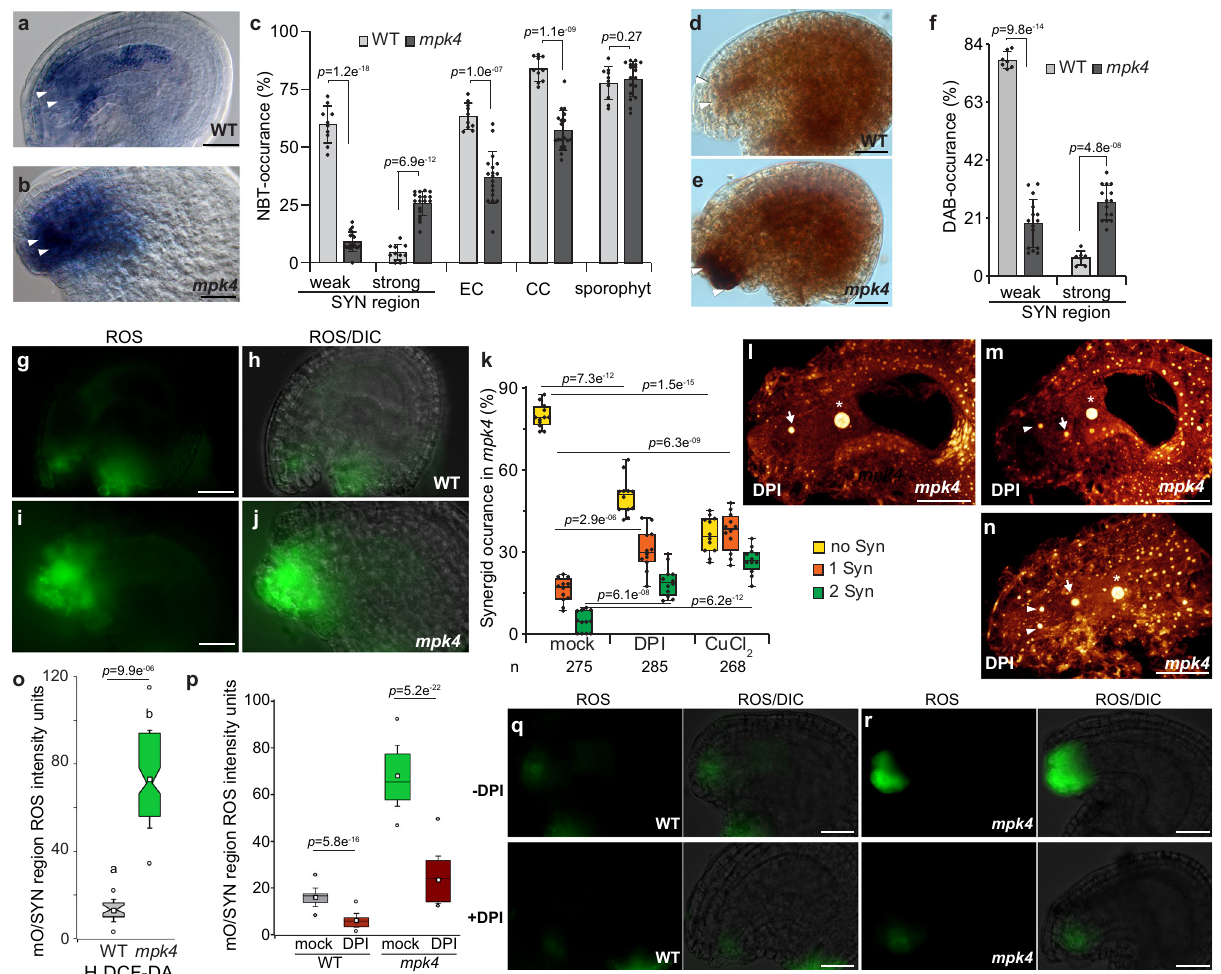
Fig. 3 MPK4 inhibits a ROS maximum at the entrance of the female gametophyte. a – c Superoxide detection in the sporophytic ovule tissue and the female gametophyte following nitroblue tetrazolium (NBT)-staining in WT ( n = 281) and mpk4 ( n = 272), three biological replicates analyzed. d – f Hydrogen peroxide detection in the sporophytic ovule tissue and the female gametophyte following diaminobenzidine (DAB)-staining in WT ( n = 203) and mpk4 ( n = 152), three biological replicates analyzed. g – j , o ROS accumulation in WT ( g , h ) and mpk4 ( i , j ) in the micropylar ovule (mO) region shown by H 2 DCF-DA staining. o Quanti fi cation of ROS-intensity units (arbitrary) in WT ( n = 283) and mpk4 ( n = 196) by imageJ. Boxes represent the 25th and 75th percentiles, and the inner rectangle highlights the median, whiskers show the SD, and outliers are depicted by dots (Min/max range). mO/SYN, micropylar ovule/synergid region. k – n Pistil-feeding assay by the use of ROS scavengers: mpk4 pistils of fl owers at developmental stage 12b/c (Christensen et al. 22 ) were treated with mock, DPI (250 µ M) or CuCl 2 (1 mM) for 24 h and subsequently analyzed for synergid preservation by DIC analysis. Representative images after ROS scavenger-application are shown by maximum projections of Z-stacks l – n. Three biological replicates with a total of 275 (mock), 285 (DPI) and 268 (CuCl 2 ) mpk4 ovules were analyzed. p – r Reduction of micropylar ovular ROS maximum in WT and mpk4 by DPI-application (250 µ M). Quanti fi cation of ROS-intensity units (arbitrary) in WT and mpk4 by imageJ. Boxes represent the 25th and 75th percentiles, and the inner rectangle highlights the median, whiskers show the SD, and outliers are depicted by dots (Min/max range). mO/SYN, micropylar ovule/synergid area. Three biological replicates were performed with similar results and depicted are the results of the fi rst replicate. Statistical signi fi cance was analyzed by one-way ANOVA. Source data and further statistical analysis are provided in the source data fi le. Error bars show ± SD. White arrowhead, synergid; white arrow, egg cell; white asterisk, the central cell nucleus. Scale bars, 20 µ